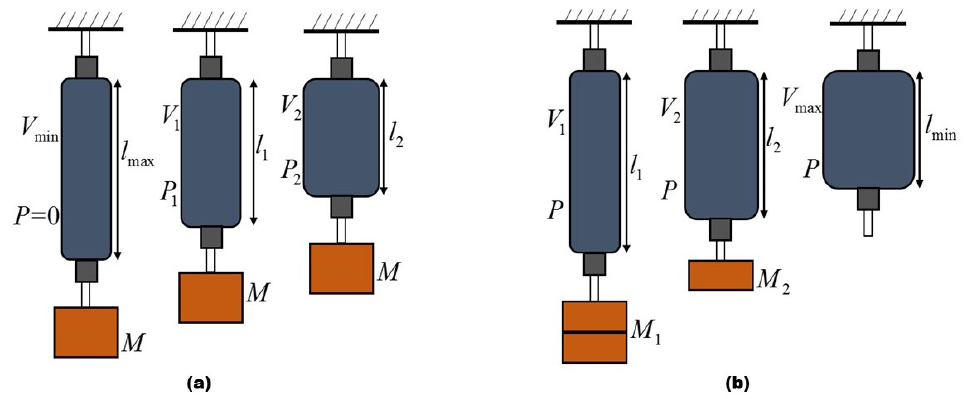
Figure 2. PAM operation: ( a ) At constant load. ( b ) At constant